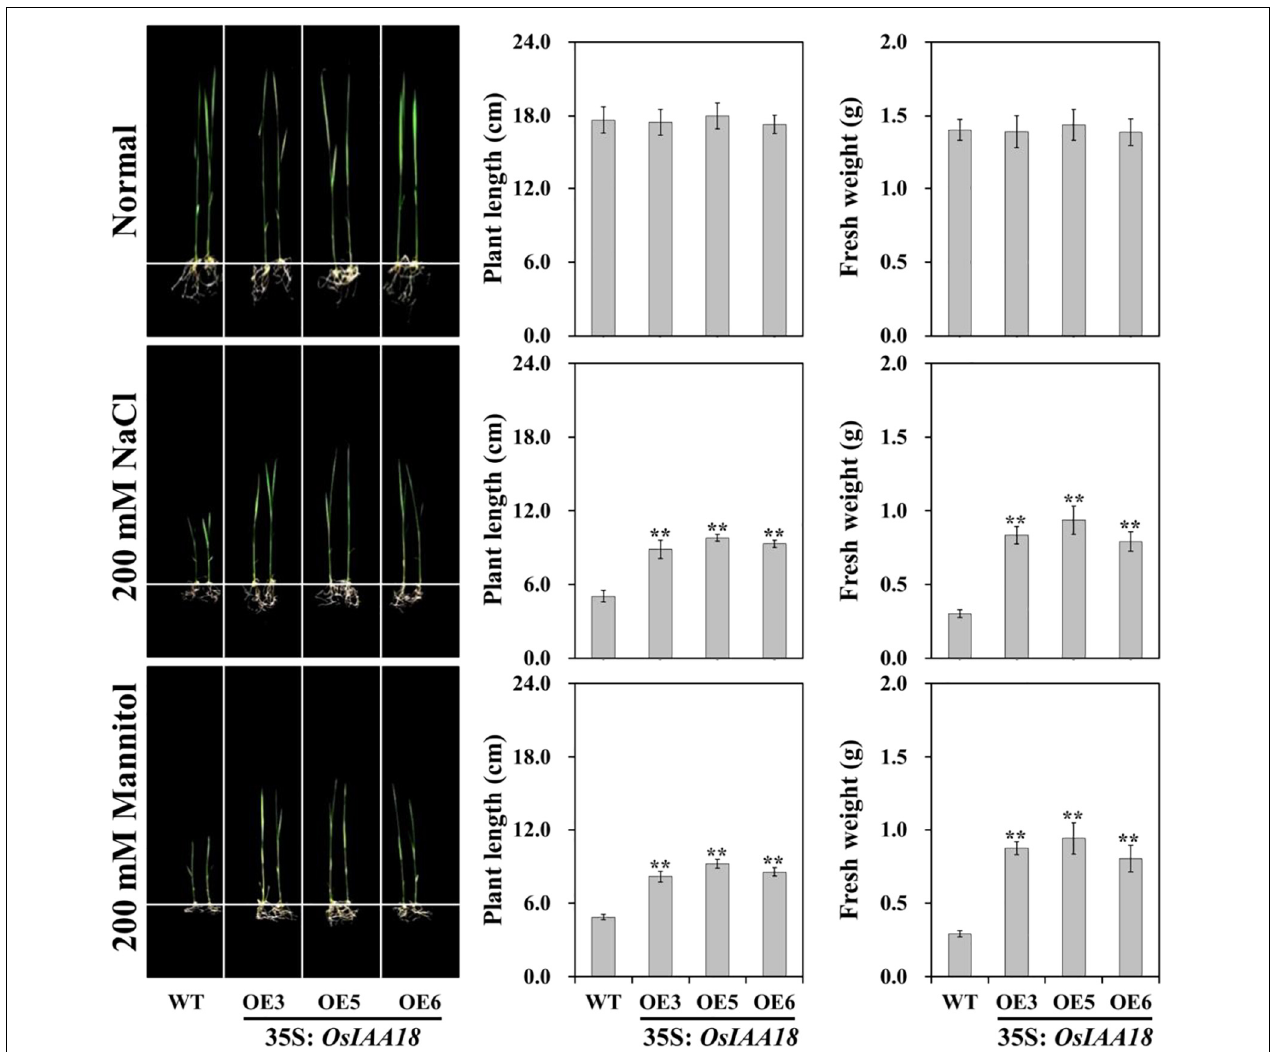
FIGURE 2 | Growth performance of overexpressing OsIAA18 and WT seedlings under 200 mM of NaCl and 200 mM of mannitol, respectively. Plant length and fresh weight of 7th-day old seedlings after transplantation. Data are presented as means ± SE ( n = 3). The values of * and ** indicate a significant difference from that of WT at P < 0.05 and < 0.01, respectively, by Student’s t